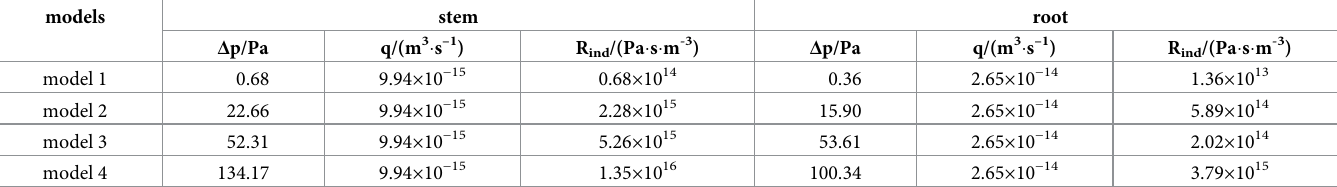
Table 3. Flow resistance of TPS in the stems and roots.